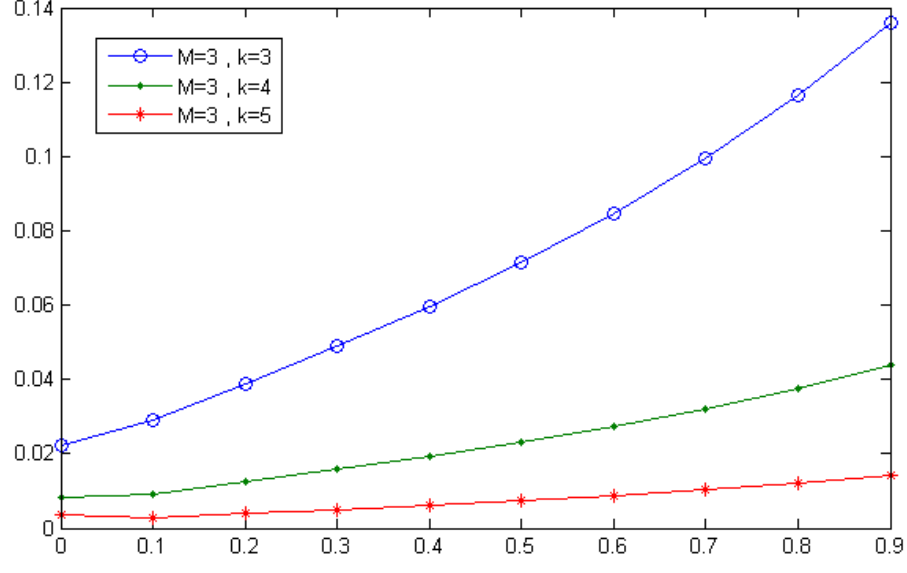
Figure 3. Absolute error of y 2 ( t ) for M = 3 and k = 3,4,5 (Example